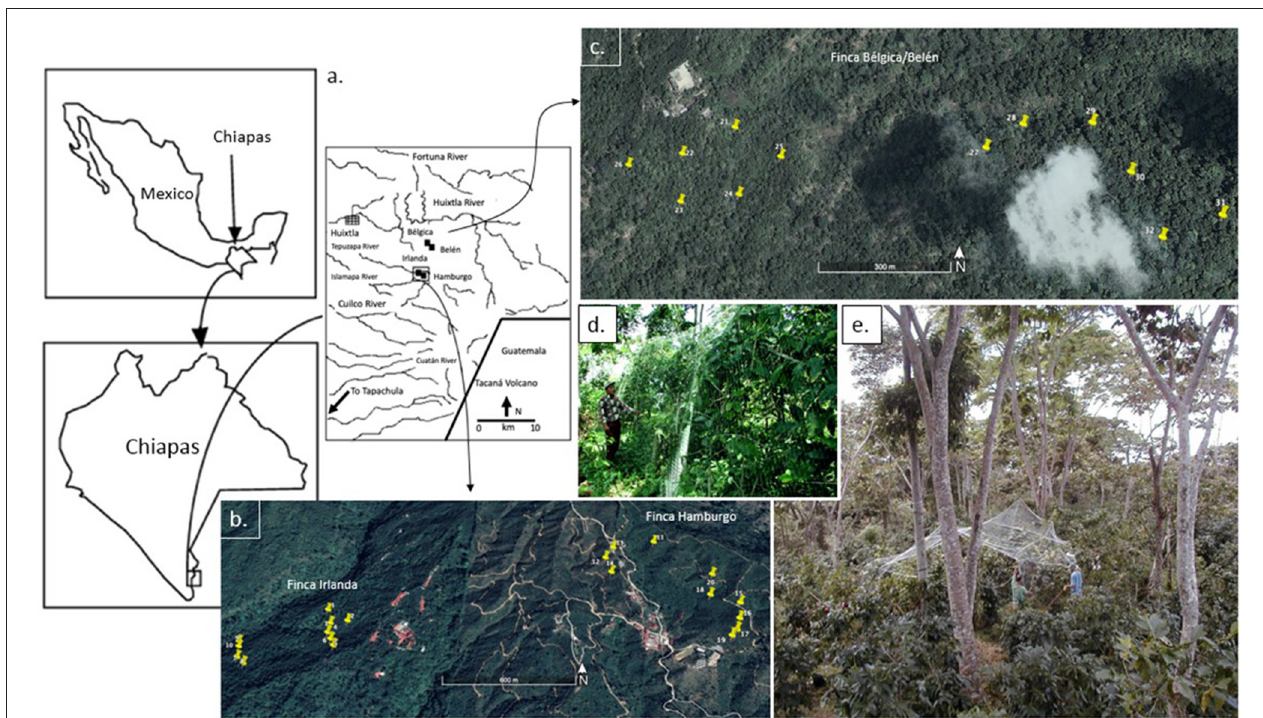
FIGURE 2 | Location of study sites and exclosures; (a) regional map indicating study sites; (b) location of exclosures in the Finca Irlanda and Finca Hamburgo sites; (c) location of exclosures in the Finca Bélgica/Belén sites; (d) photo from outside one of the exclosures; (e) setting up an